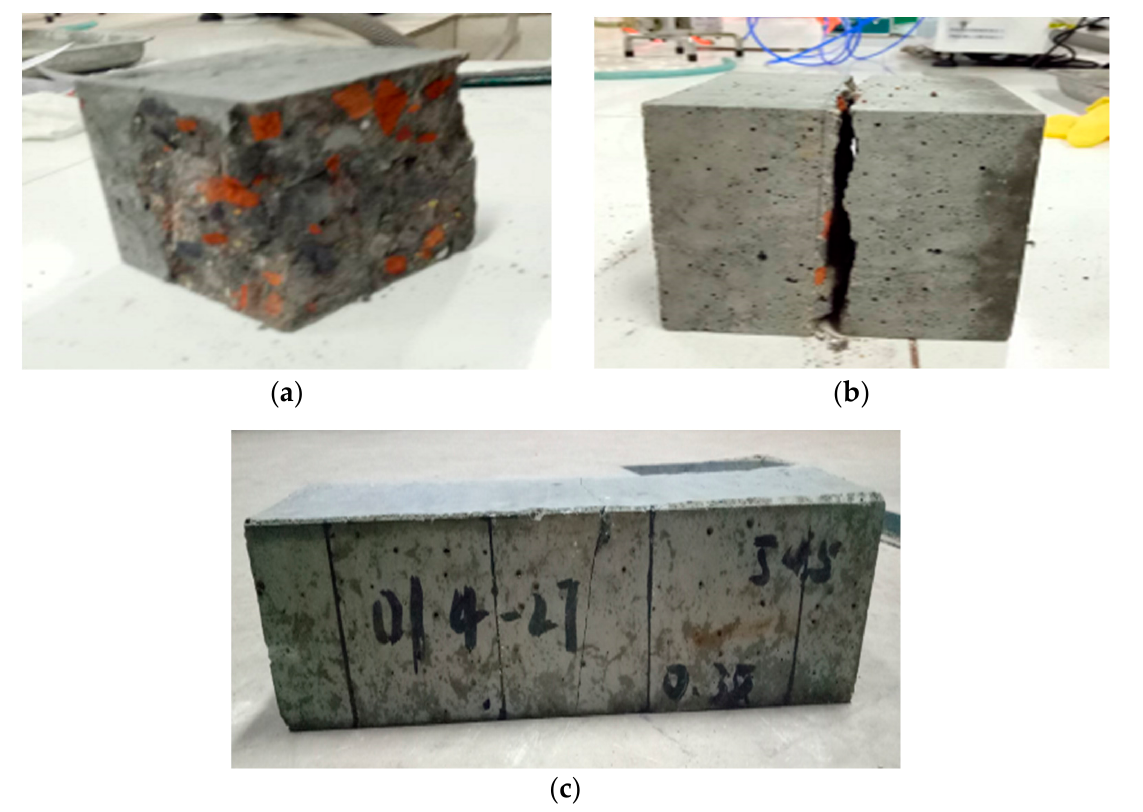
Figure 3. ( a ) Compression strength ( b ) Tensile strength ( c ) Flexural strength.